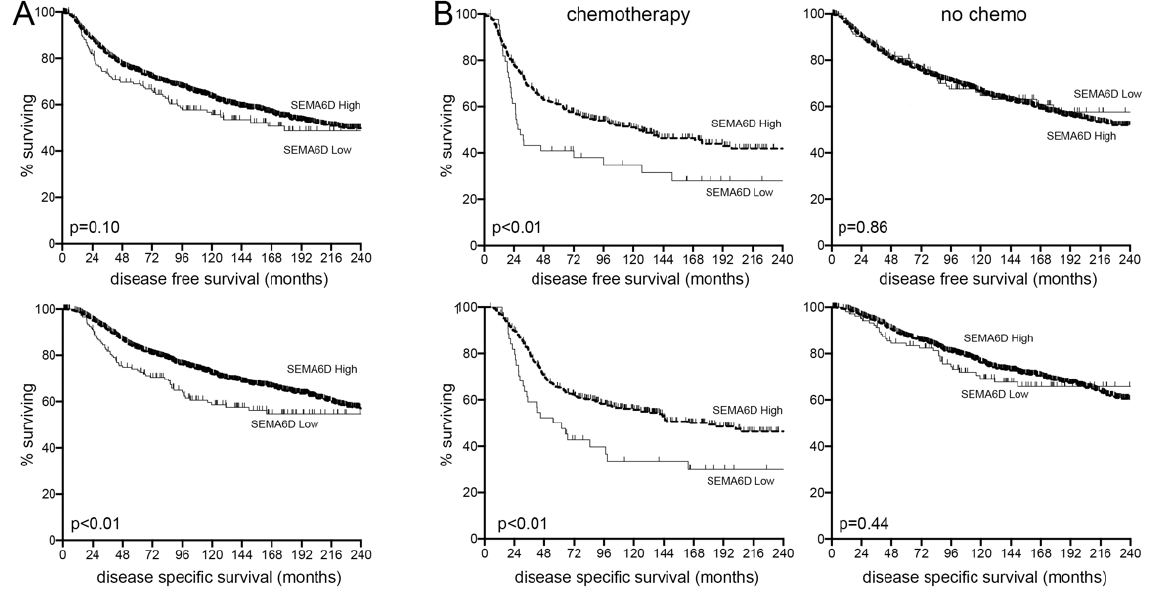
Figure 4. Low SEMA6D expression predicts poor survival in breast cancer patients specifically after chemotherapy. METABRIC transcriptomic data for breast cancers were accessed via cbioportal and records with SEMA6D expression data and suitable clinical annotation were identified ( n = 1979). Kaplan–Meier survival analyses for disease-free survival (DFS; top plots) or disease–specific survival (DSS; bottom plots) were performed, comparing the relatively low and high SEMA6D expression groups within the full cohorts ( A ) or within those treated with chemotherapy ( B left plots; n = 412) and those treated without ( B right plots; n = 1567). Significance was assessed using Log Rank tests.